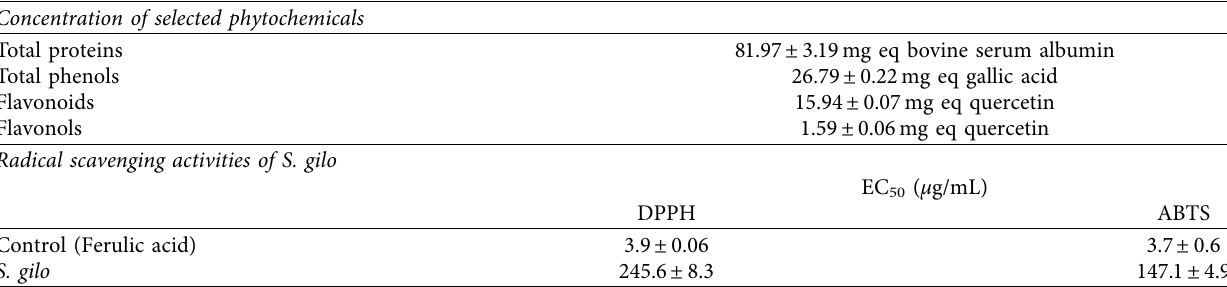
Table 1: Quantitative phytochemical analyses and scavenging free radical activities of S. gilo hydroethanolic extract. Concentration of selected